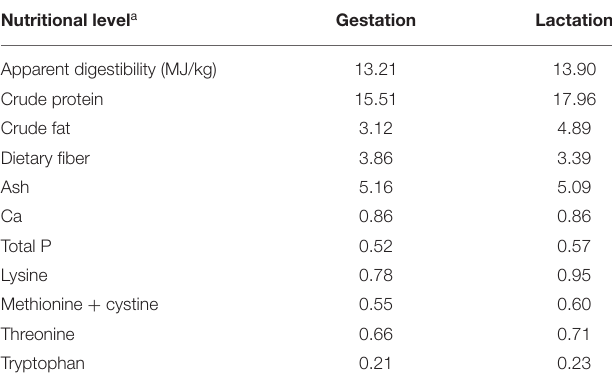
TABLE 1B | Composition and nutritional value of the diet (as-fed